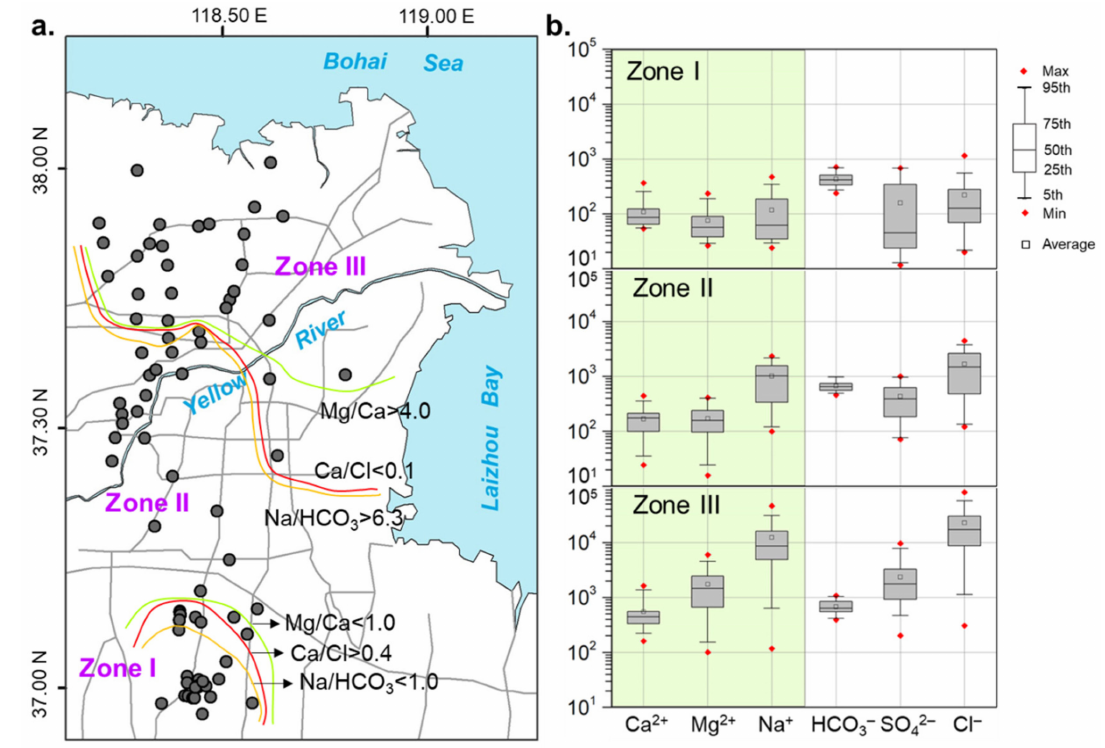
Figure 8. Hydrogeochemical zonation ( a ) and ionic concentrations (mg/L) in different zones ( b